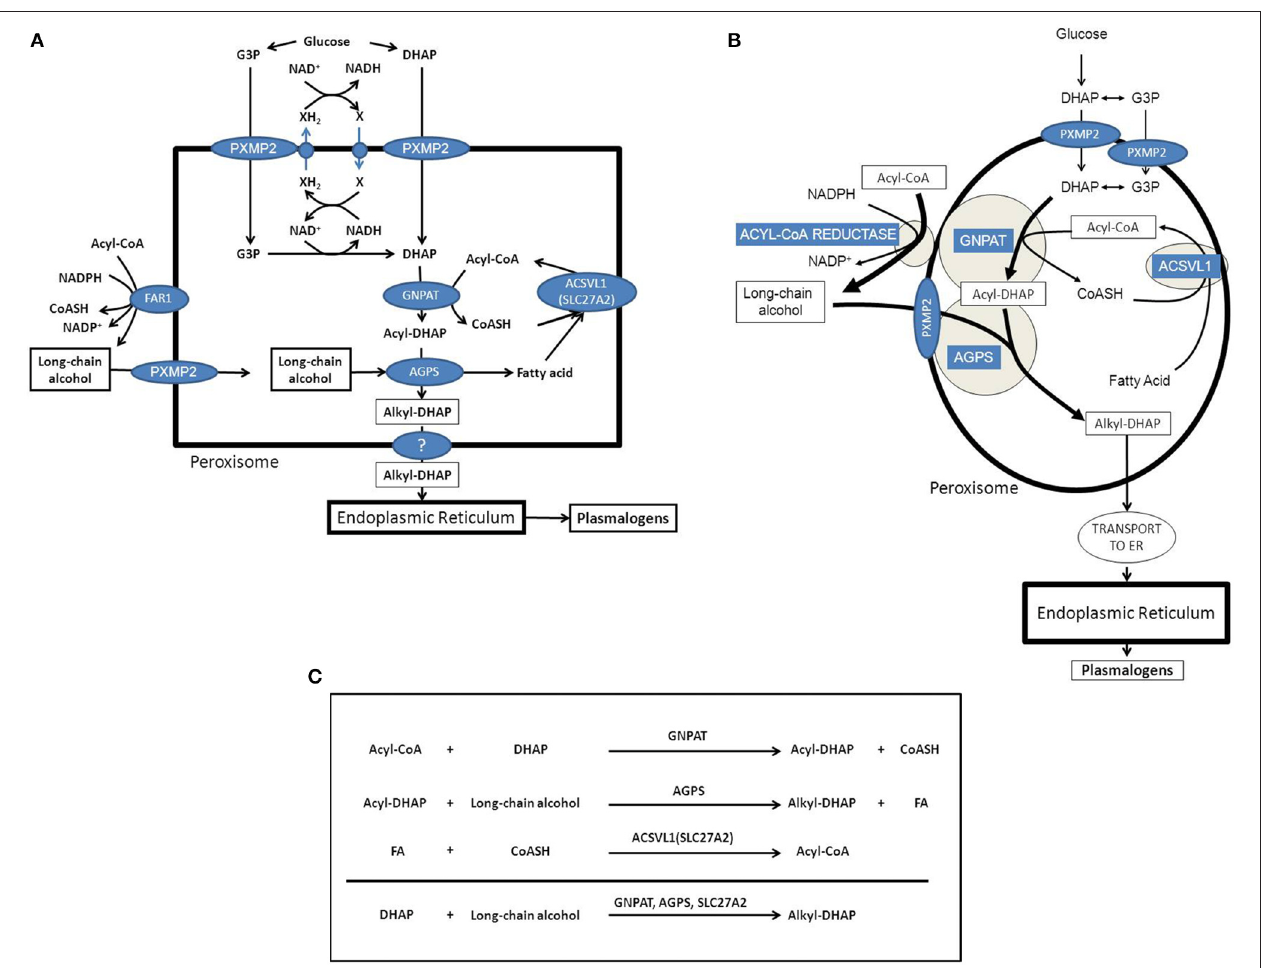
FIGURE 2 | Etherphospolipid biosynthesis and the important role of peroxisomes and the endoplasmic reticulum. (A) Schematic representation of the peroxisome and the enzymes and transporters involved in the peroxisomal synthesis of alkyl-DHAP. (B) Schematic representation of the peroxisome and the enzymes and transporters involved in the peroxisomal synthesis of alkyl-DHAP with special emphasis on the sub-peroxisomal localization of GNPAT and AGPS as peripheral peroxisomal membrane proteins joined together in a functional complex. (C) Overview of the reactions catalyzed by the three intraperoxisomal enzymes involved in etherphospholipid synthesis including GNPAT, AGPS, and ACSVL1 (SLC27A2). G3P, glycerol-3-phosphate; DHAP, dihydroxyacetonephosphate; GNPAT, glyceronephosphate O-acyltransferase; AGPS, alkyl-glyceronephosphate synthase; FAR1, fatty acyl-CoA reductase